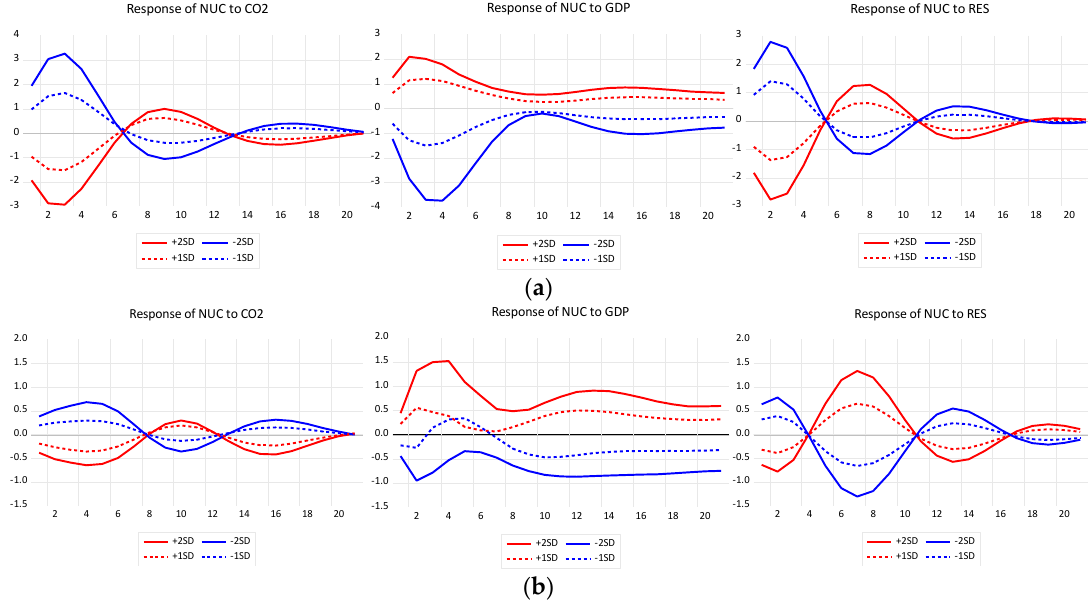
Figure 5. Responses of nuclear energy consumption to shocks in CO 2 emissions, GDP and renewable energy consumption in ( a ) upper regime; ( b ) lower regime.